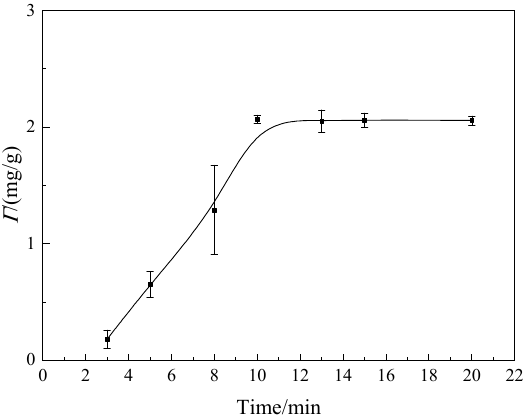
Figure 4. Relationship between the adsorption capacity and the adsorption time.